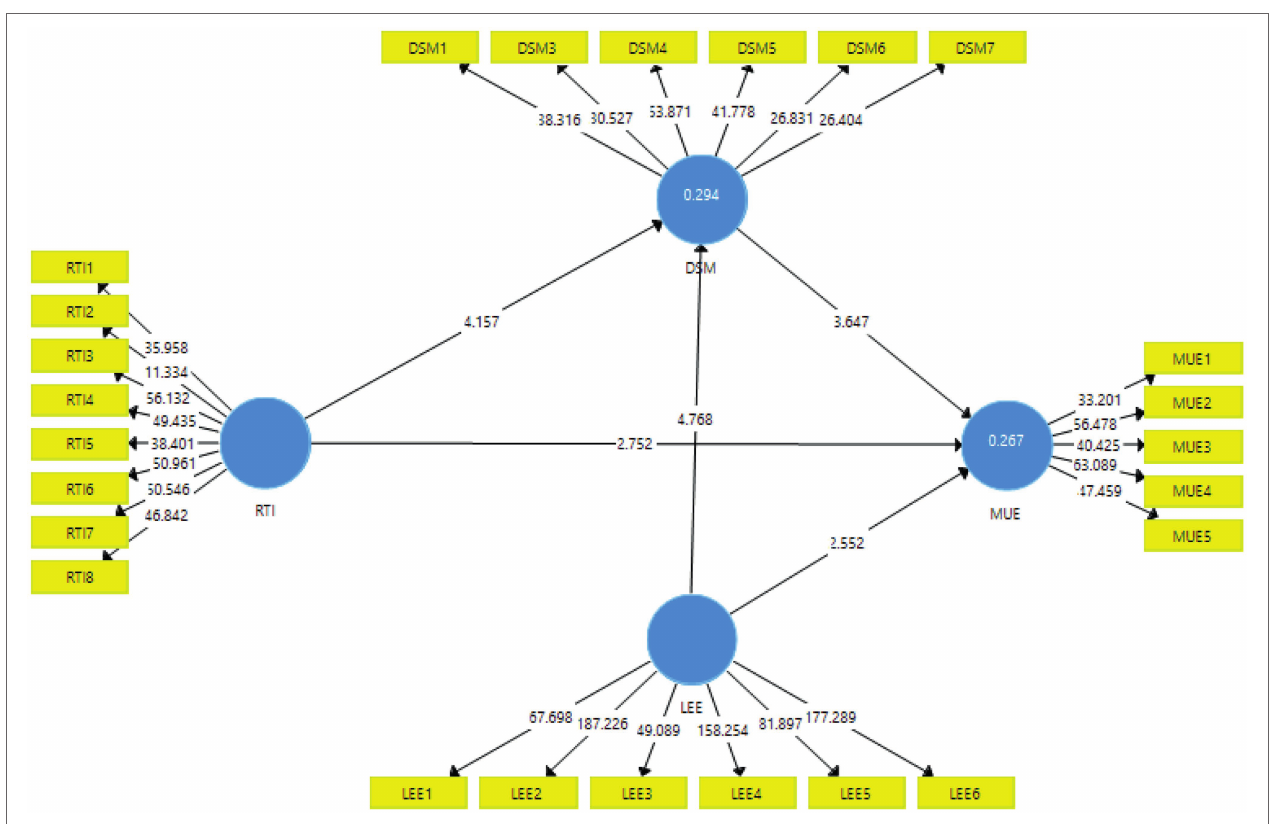
FIGURE 3 | Structural model